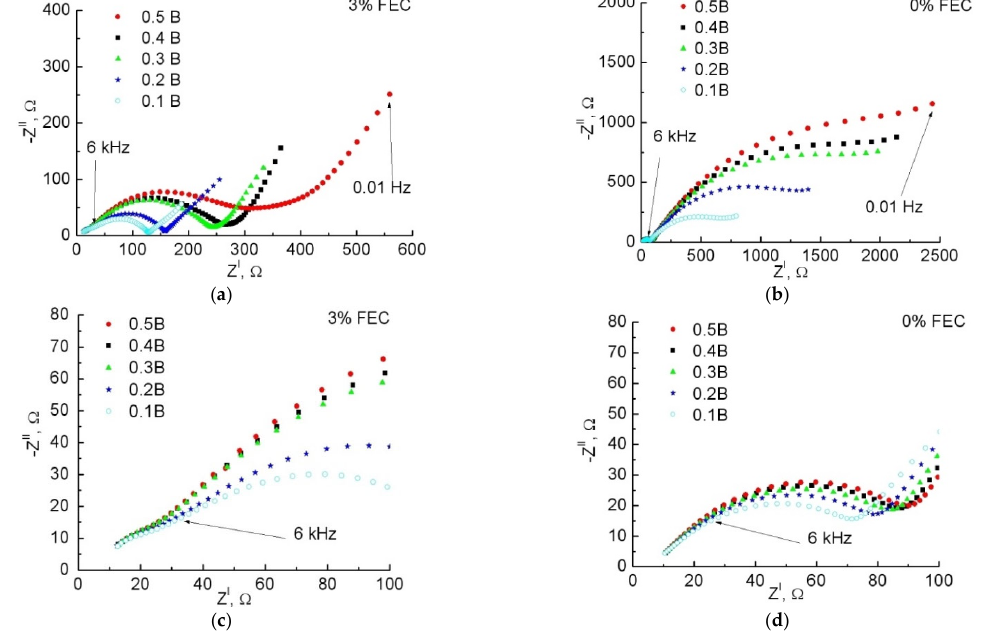
Figure 8. General view ( a , b ) and high-frequency region ( c , d ) of impedance hodographs at different charge voltages specified in the legend for samples with 3% FEC ( a , c ) and 0% FEC ( b , d ).